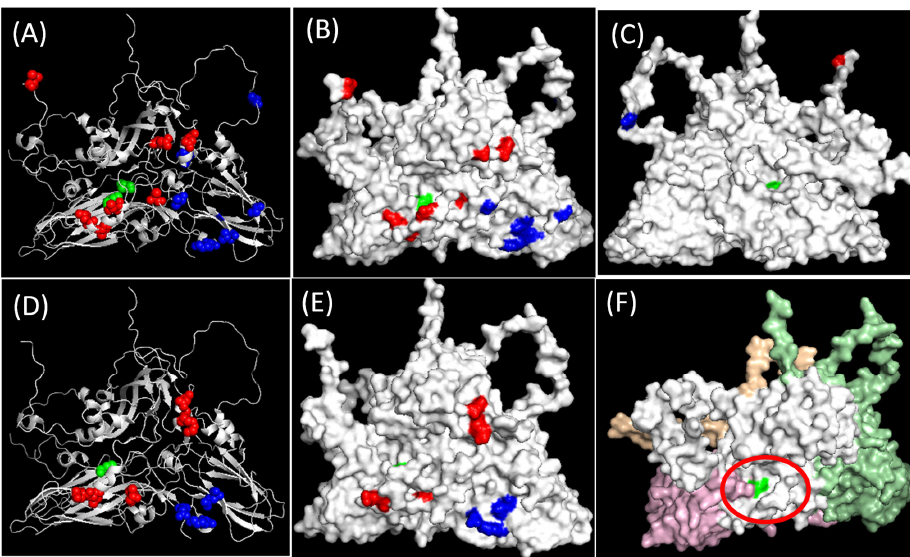
Figure 3. ( A – C ): Three-dimensional (3D) structure of the cartoon ( A ), external surface ( B ) and internal surface ( C ) of the O BFS-reduced protomer (1FOD, reduced) showing the aa variability of O SEA viruses. The residues in VP1, VP2 and VP3 are shown as red, green and blue spheres, respectively. ( D – F ). 3D structure of the cartoon ( D ), external surface ( E ) and internal surface ( F ) of the O BFS-reduced protomer (1FOD, reduced) showing aa residues, mainly responsible for the antigenic drift in serotype O/Cathay viruses as identified in this study, showing VP2-130 (shown in green) at the bottom of the pocket. The residues in VP1, VP2, VP3 and VP4 are shown in gray, pink, pale green and wheat, respectively. Red circle indicates the pocket, a possible antibody-binding site. The images were generated using PyMoL software (PyMOL Molecular Graphics System, Version 2.0, Schrodinger, LLC).